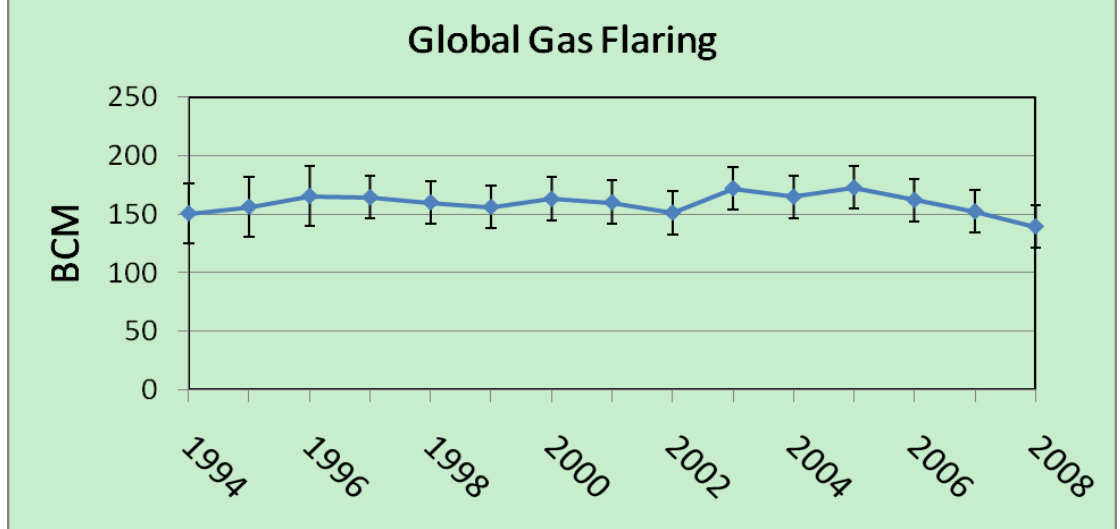
Figure 10. Global gas flaring volume has been in the range of 140 to 170 BCM from 1994 to 2008. The peak was 2005 with 172 BCM and flare volume has been declining since that time. The estimated error (σ) of each global total is generated from the square root of the sum of errors of each country squared (σ i2 ). In years where estimates were made using data from a single satellite the estimated error is 23.8 BCM (1994, 1995, 1996). In subsequent years the estimated error is reduced to 16.9 BCM based on the inclusion of separate flare volume estimates from two